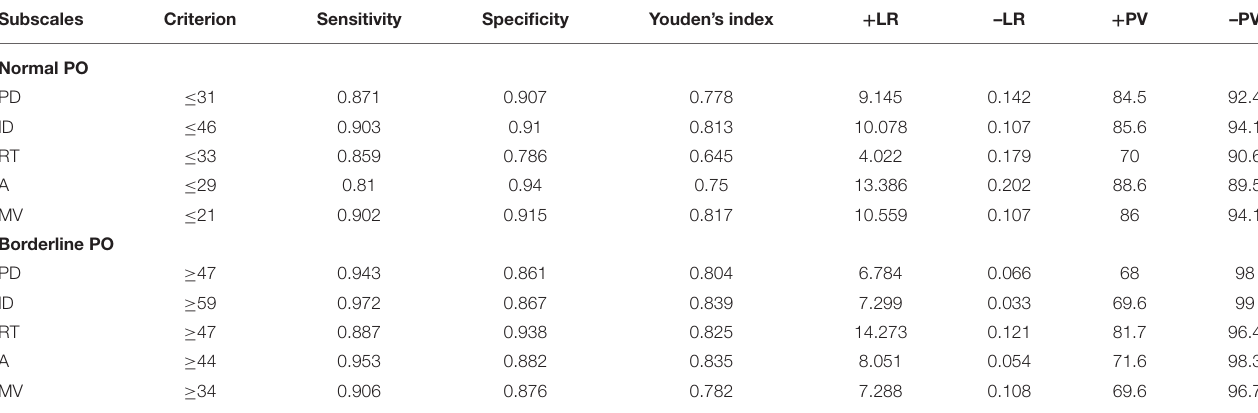
TABLE 2 | Cut-off scores and precision indexes for the normal and borderline personality organisations on the IPO scales for older adults (age ≥ 65 years). Subscales Criterion